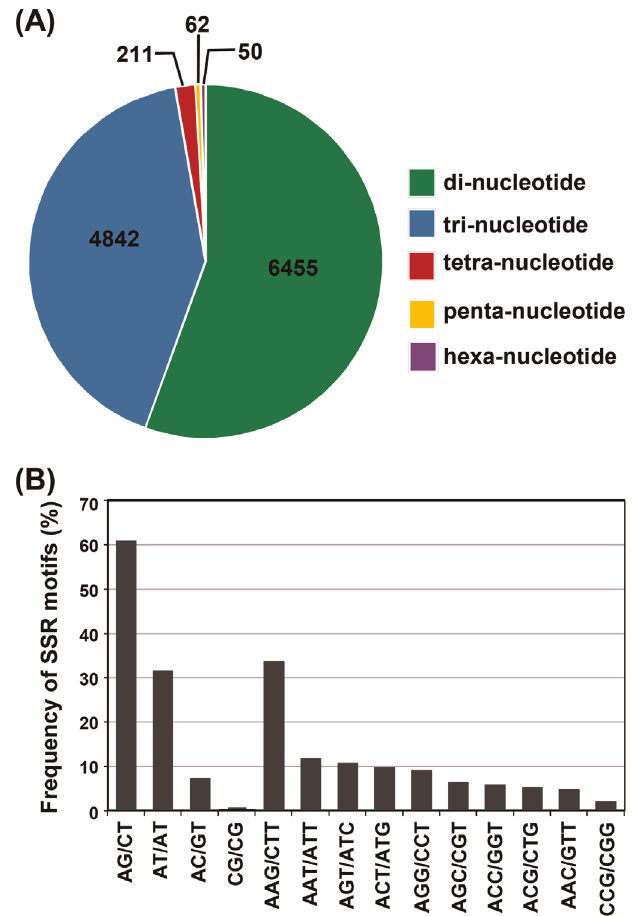
Table 2. Mapping of non-redundant high-quality reads on C. roseus transcriptome.